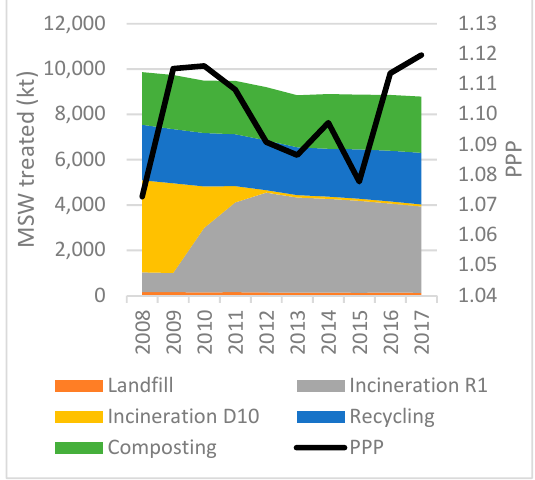
Figure 38. Waste treatment methods and PPP in The Netherlands 2008–2017 (EUROSTAT 2019b, 2019c).